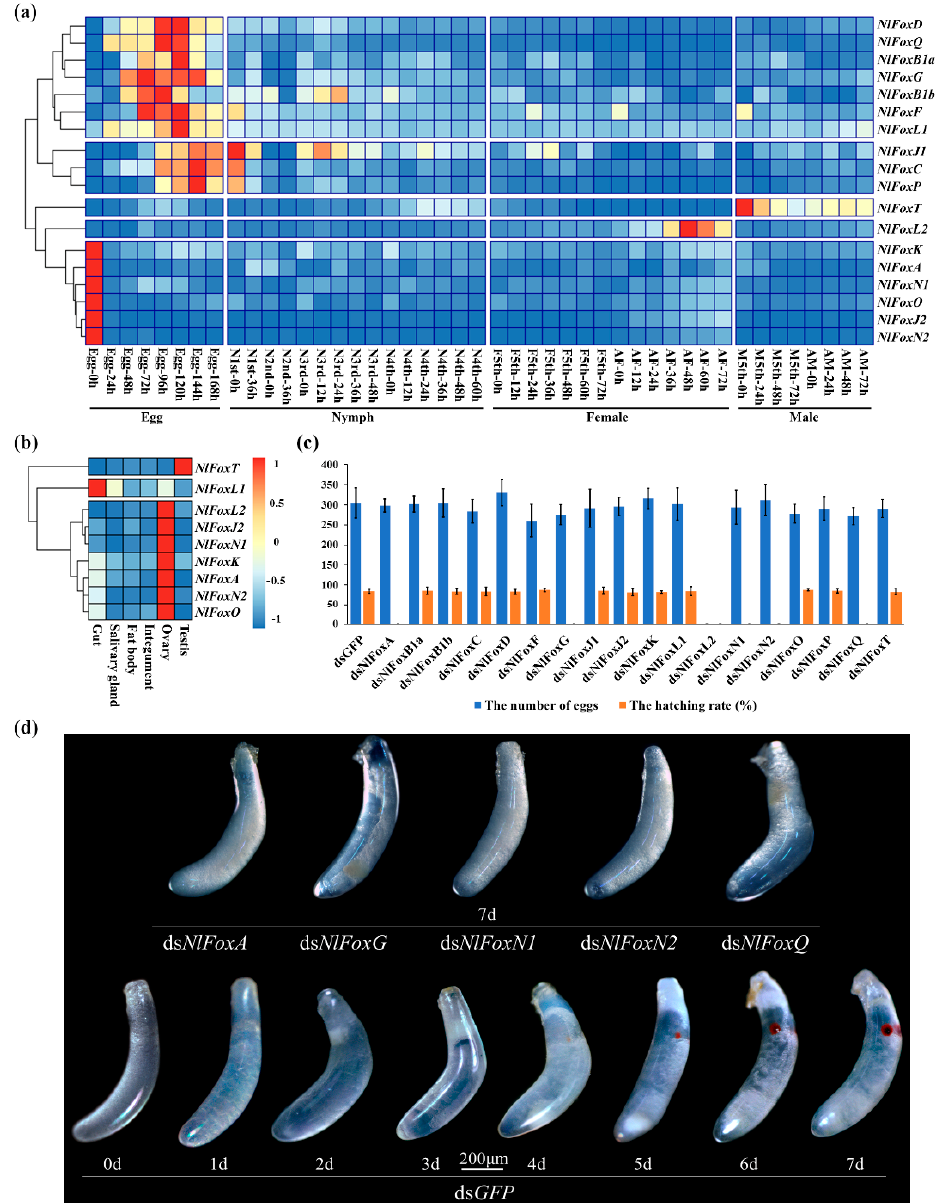
Figure 2. N. lugens Fox genes are highly expressed in eggs and play indispensable roles in fecundity and hatchability. ( a ) Expression patterns of Fox genes in different development stages. N: nymph; AF: adult female; M: male; AM: adult male. ( b ) Expression patterns of Fox genes in different tissues. ( c ) Effect of RNAi on fecundity and hatchability. DsRNA except for NlFoxT (50 ng per insect; n = 100) was injected into newly emerged female adults (within two hours). DsRNA for NlFoxT (50 ng per insect; n = 100) was injected into newly emerged male adults (within two hours). Mean ± standard error of the mean (s.e.m.) from three experiments. ( d ) The lethal phenotypes of eggs injected with dsRNA for N. lugens Fox genes. DsRNA for NlFoxA , NlFoxG , NlFoxN1 , NlFoxN2 and NlFoxQ (50 ng per insect; n = 100) was injected into newly emerged female adults (within two hours). Ds GFP was injected as a negative control for the nonspecific effects of